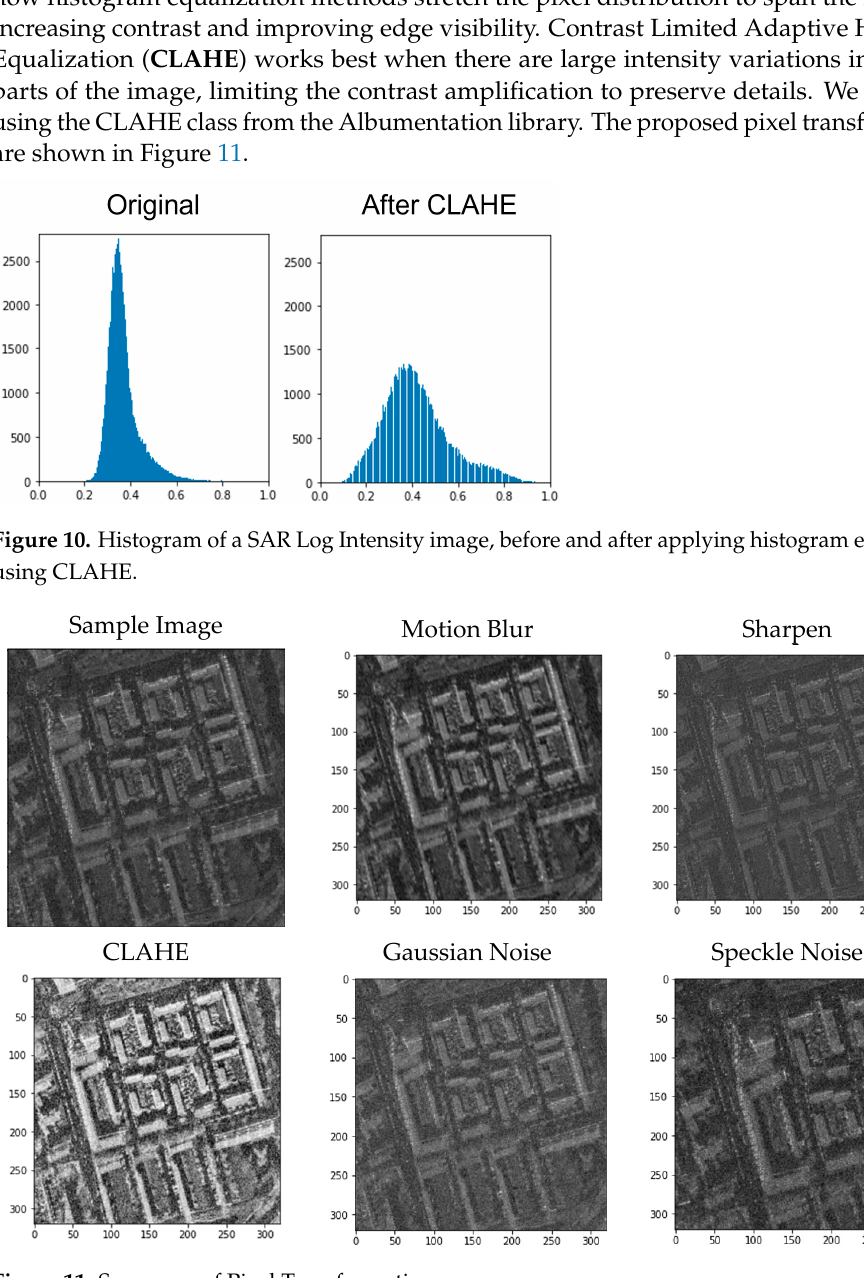
Figure 9. Summary of Geometric Transformations.